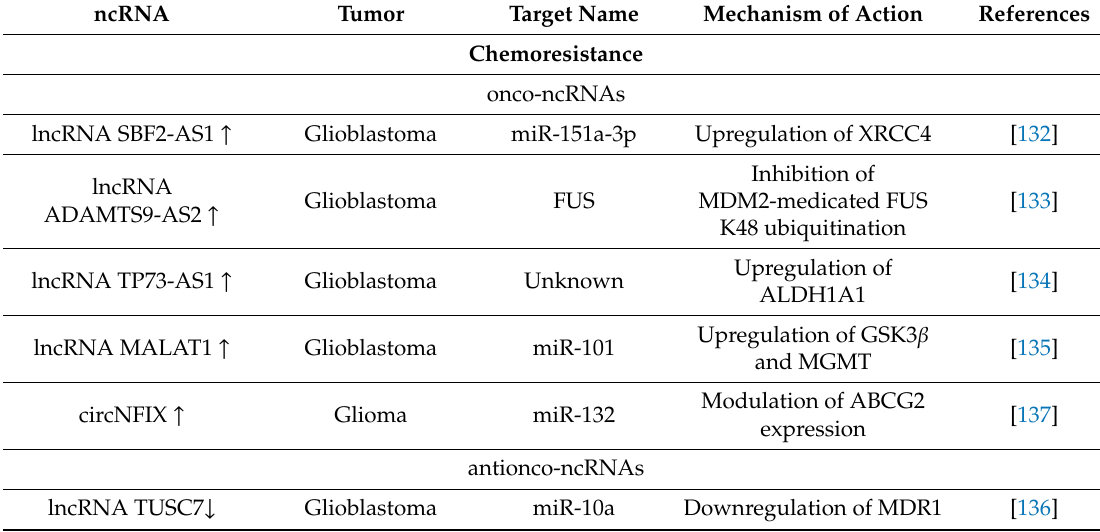
Table 4. Oncogenic or tumor-suppressive lncRNAs and circRNAs involved in regulation of cancer cell